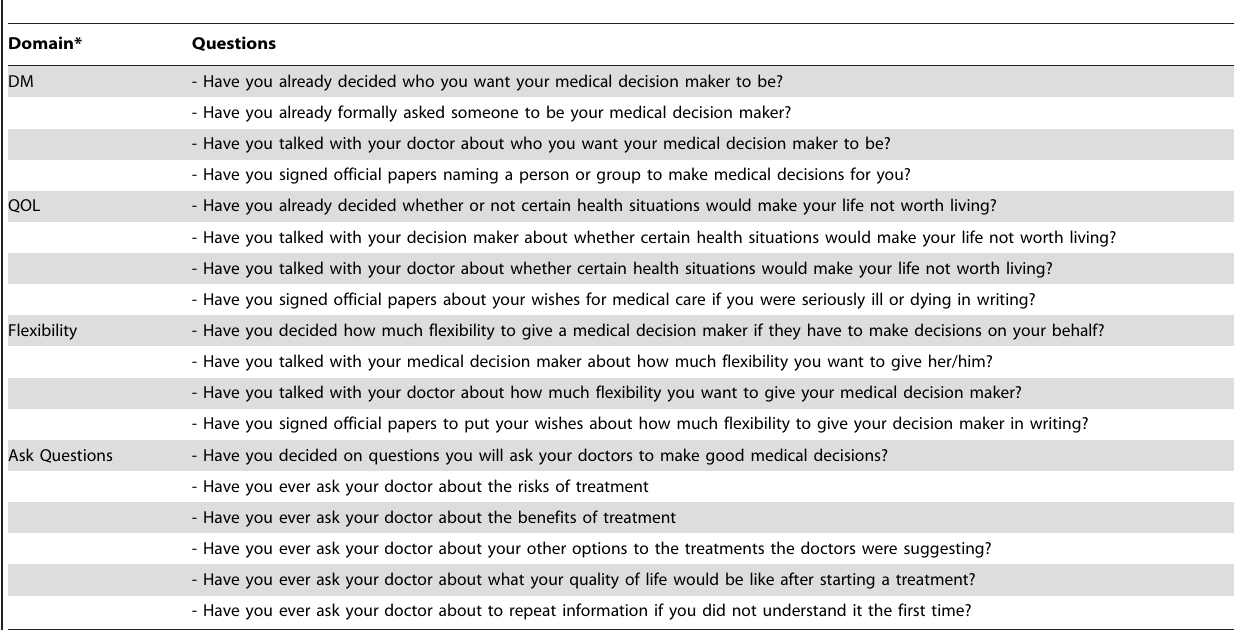
Table 2. Advance Care Planning Engagement Survey – Action Measures: Advance Care Planning Domains and Questions.